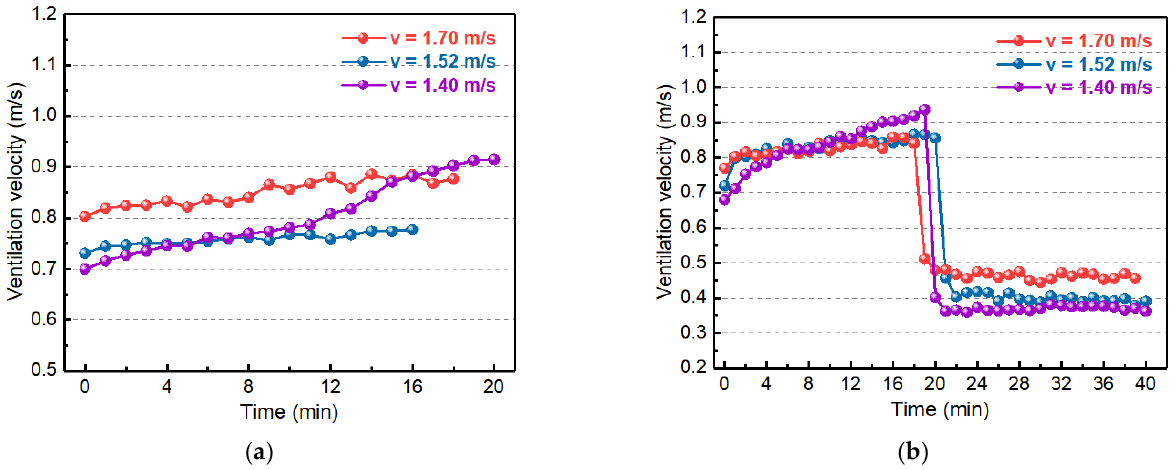
Figure 4. Wind velocity of adjacent branches for different schemes: ( a ) Air-door 5 closed. ( b ) Air- door 5 half closed.